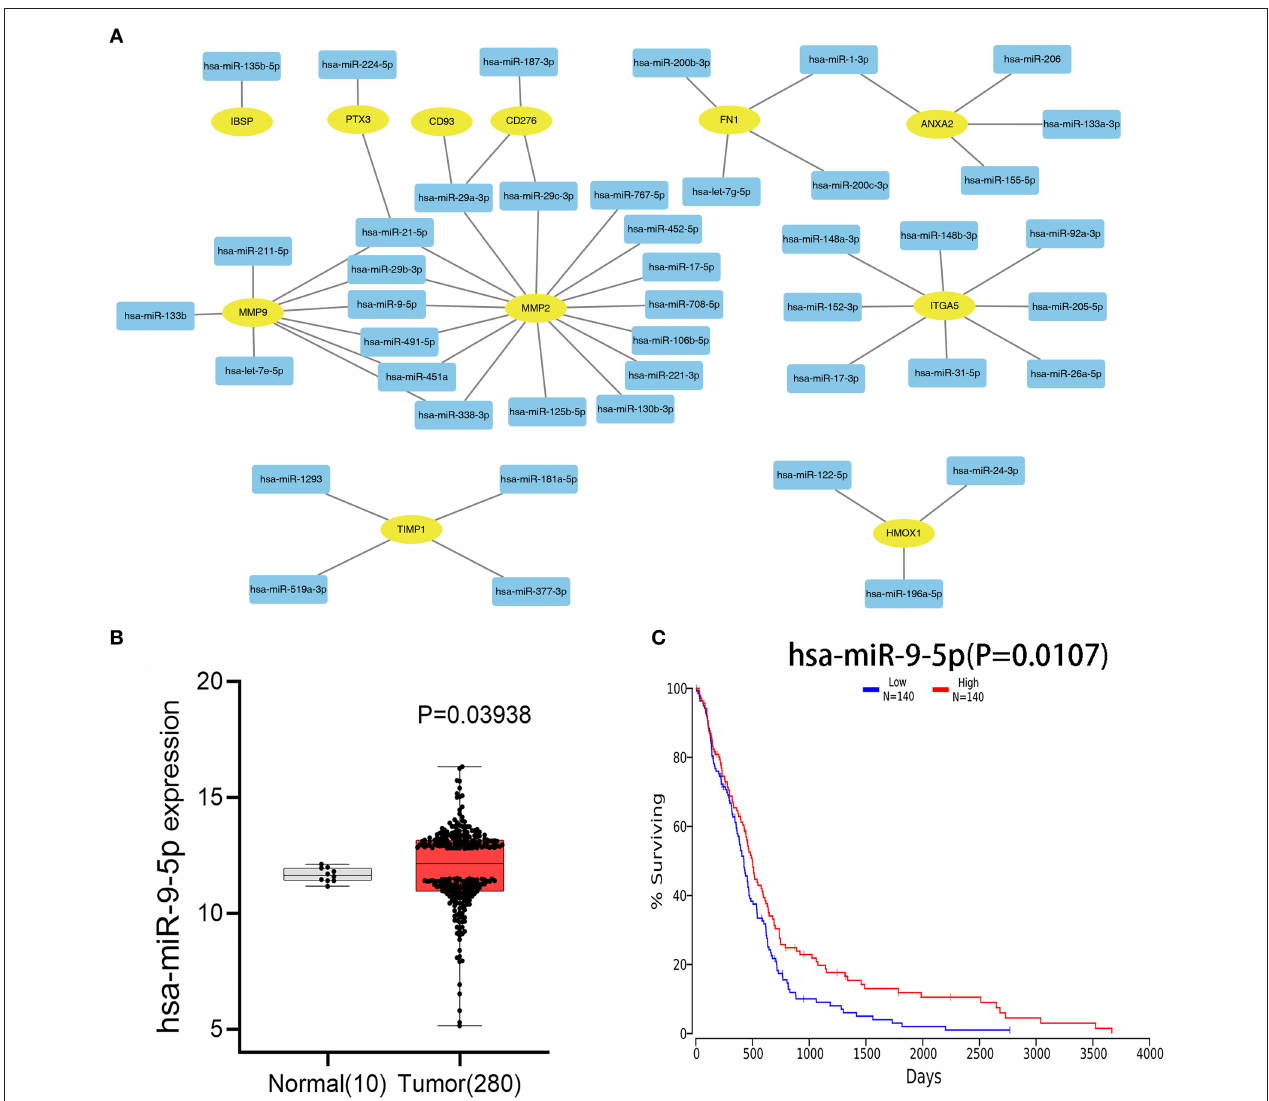
FIGURE 3 | Identification of upstream miRNAs. (A) The mRNA–miRNA network constructed by cytoscape software. The rectangle in the network represents miRNA, and the ellipse represents hub genes. (B) Differential analysis of miR-9-5p gene expression between Tumor (GBM) group and normal brain tissue group. (C) The prognostic values of miR-9-5p in patients with